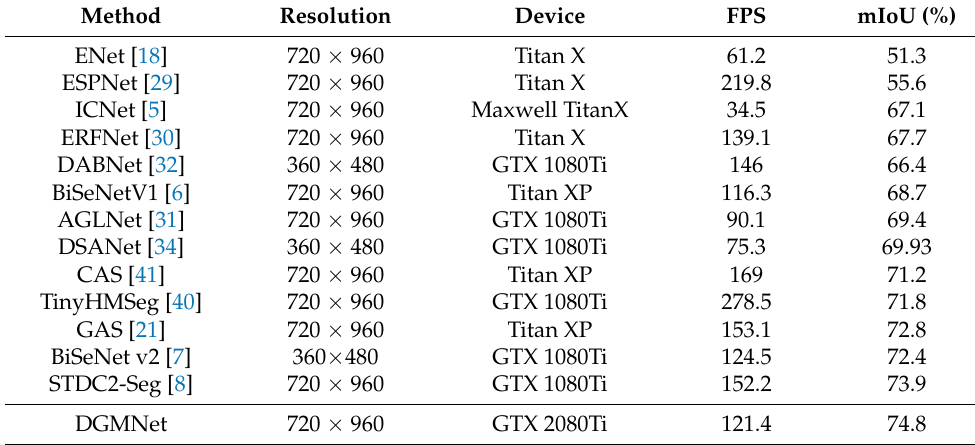
Table 5. Comparisons with other state-of-the-art methods on